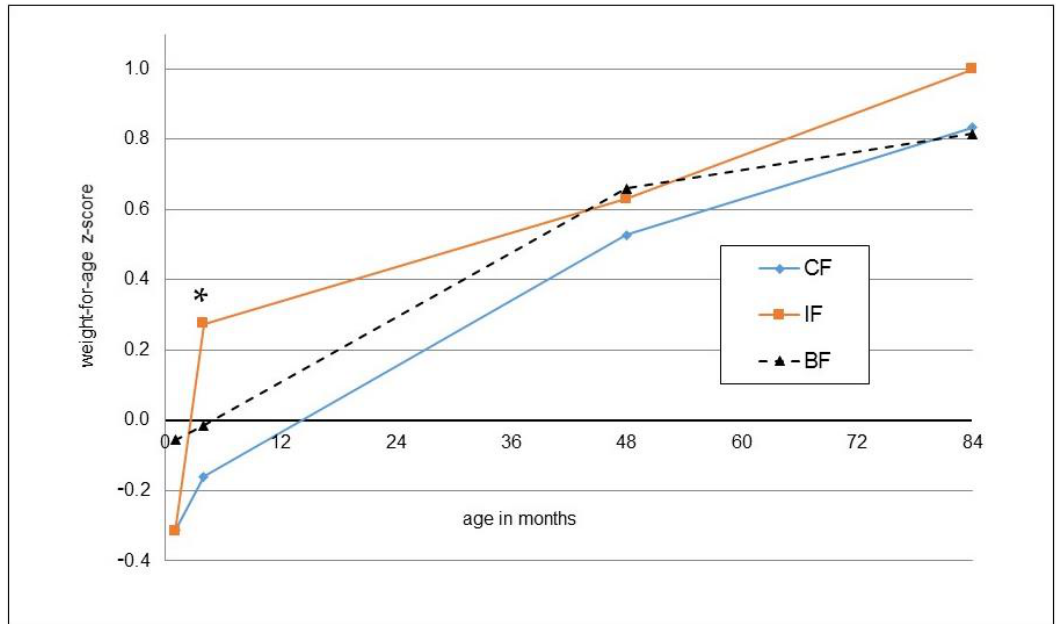
Figure 2. Mean z-scores for weight-for-age at one month (IF: n = 50, CF: n = 54, BF: n = 57), four months ( n = 50, n = 54, n = 57), four years ( n = 48, n = 52, n = 57) and seven years ( n = 50, n = 54, n = 57) for those children participating in the 7-year follow-up; * significant difference between IF and CF, t -test.